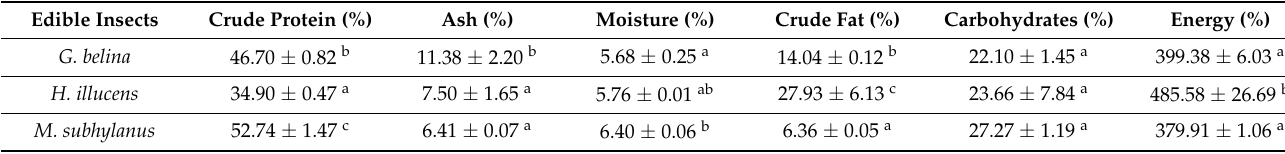
Table 1. Proximate composition of three edible insect